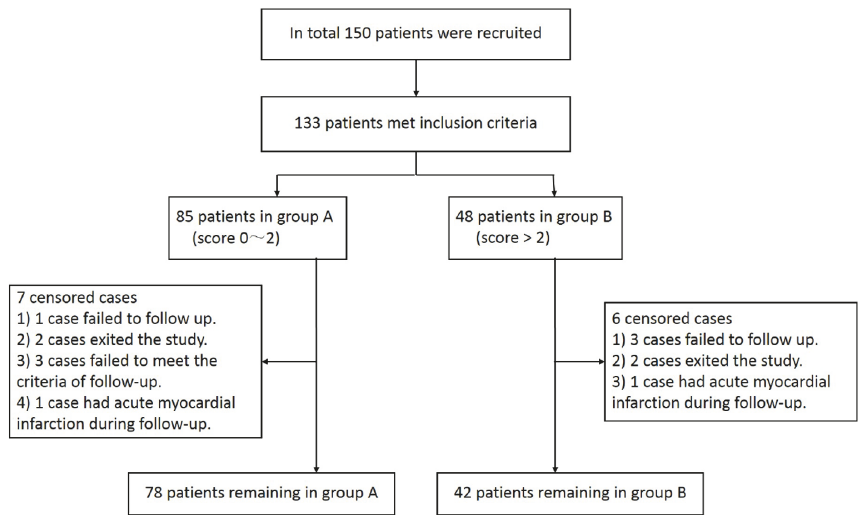
Figure 3: Flowchart of patient recruitment and selection.